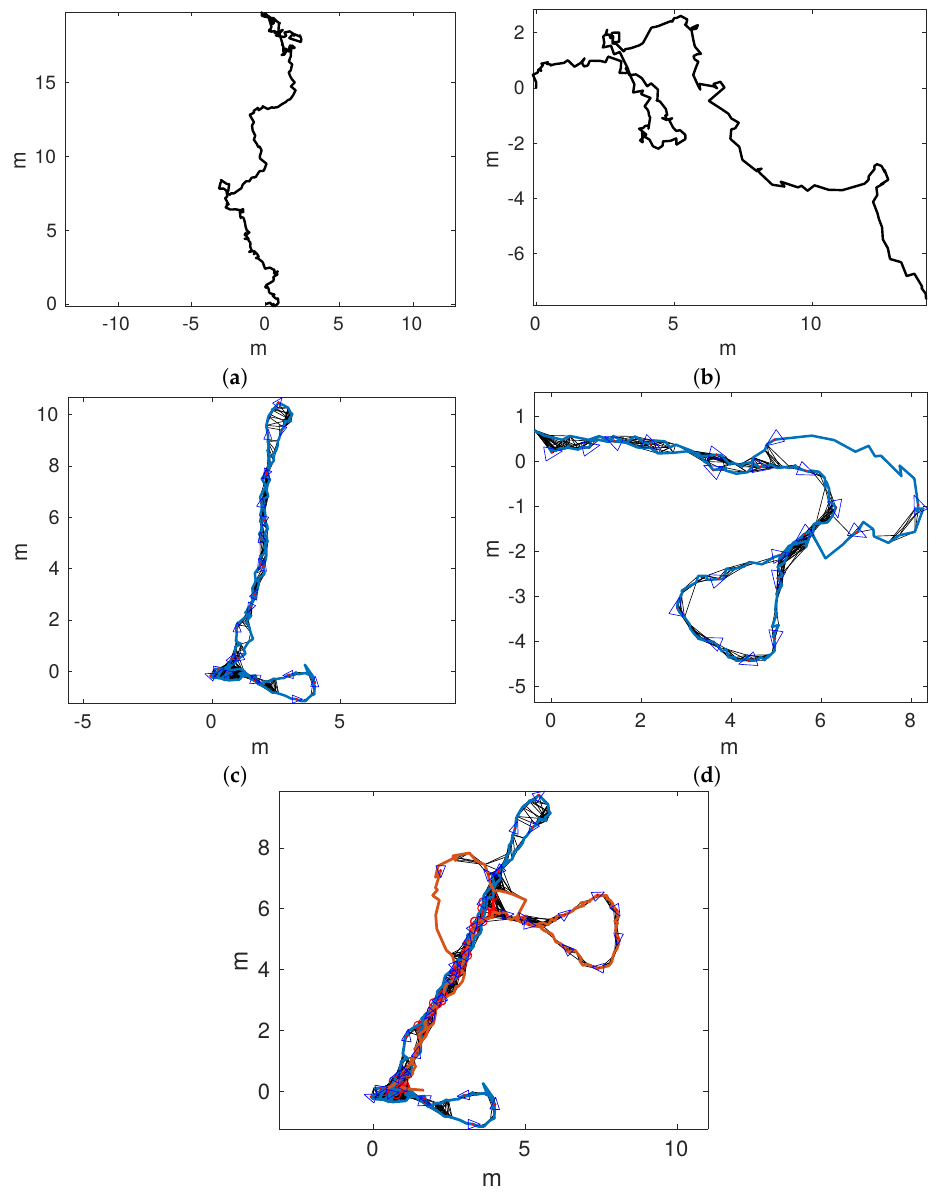
Figure 22. Example of multi-session SLAM using odometry corrupted with noise level 5: ( a ) Corrupted odometry of session 1, ( b ) corrupted odometry of session 2, ( c ) single-session SLAM of session 1, ( d ) single-session SLAM of session 2, and ( e ) multi-session